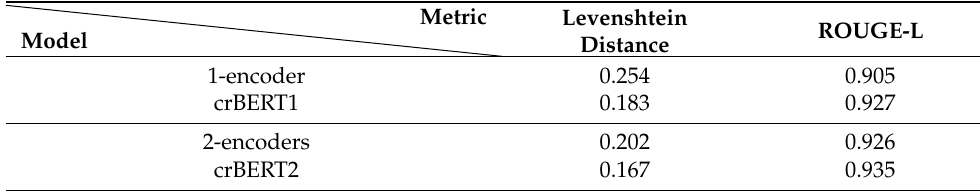
Table 5. Leweinshtein distance and rouge-L test